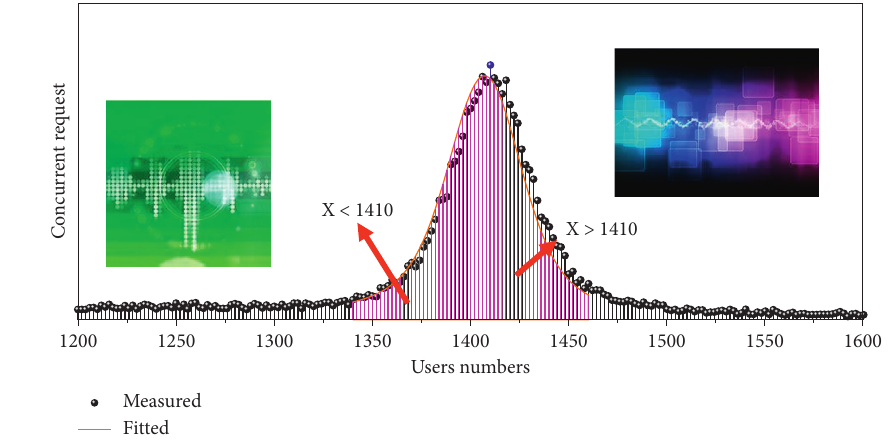
Figure 7: Concurrent request recommendation list test results.